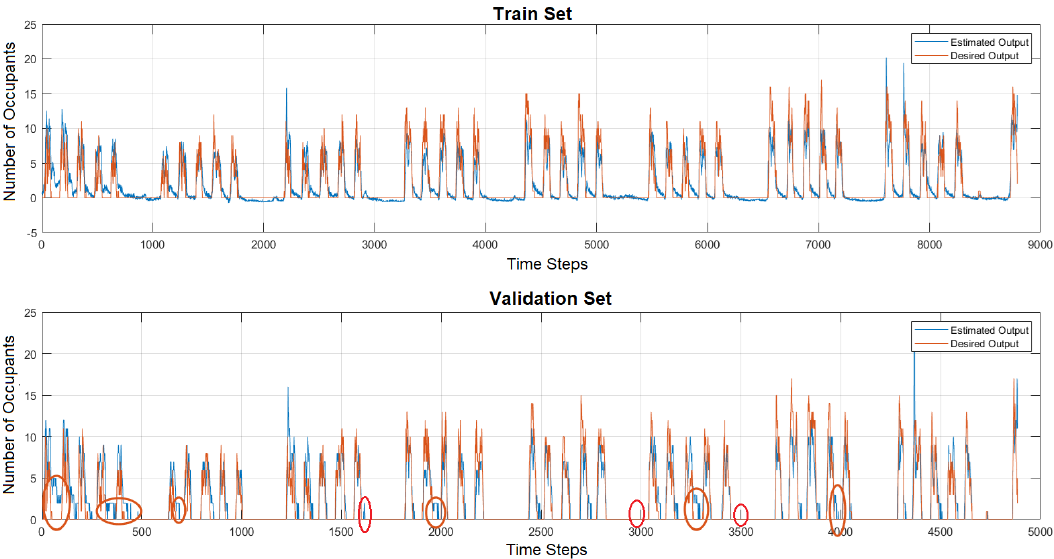
Figure 9. Occupancy prediction when the data set is unfiltered.